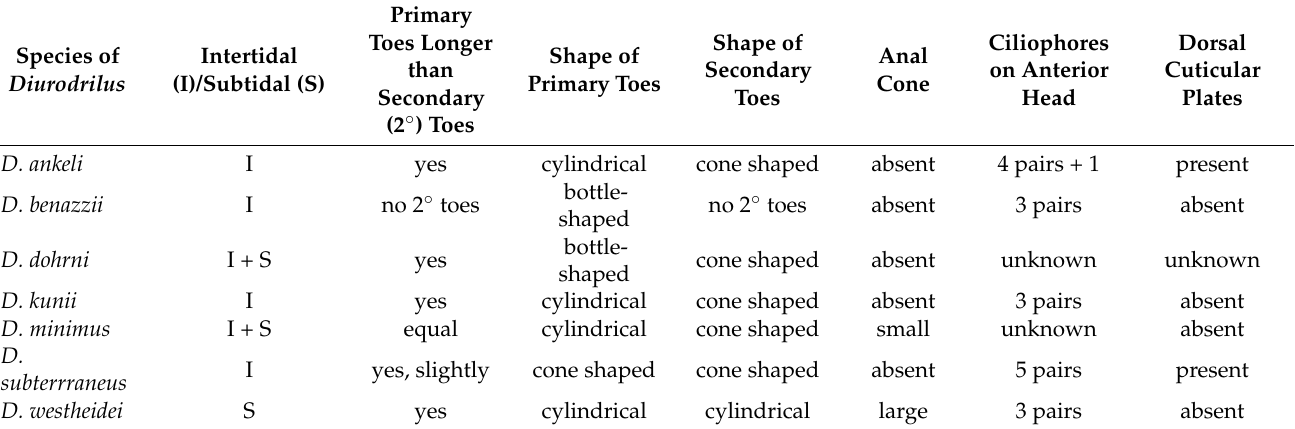
Table 1. Diagnostic characters of described species of Diurodrilus